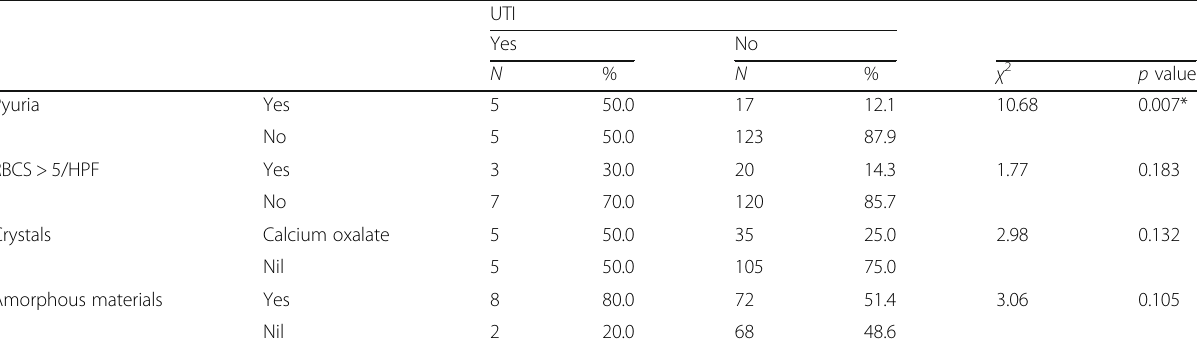
Table 6 Association of urine analysis findings and urinary tract infection